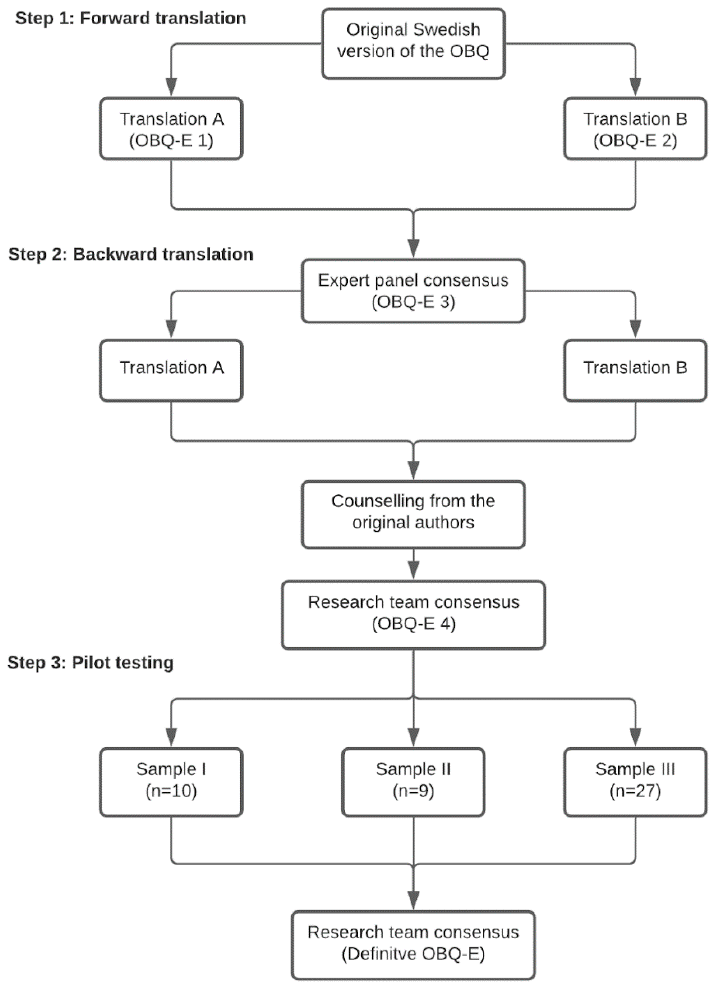
Figure 1. Flow chart for the cross-cultural adaptation and translation process of the OBQ-E.